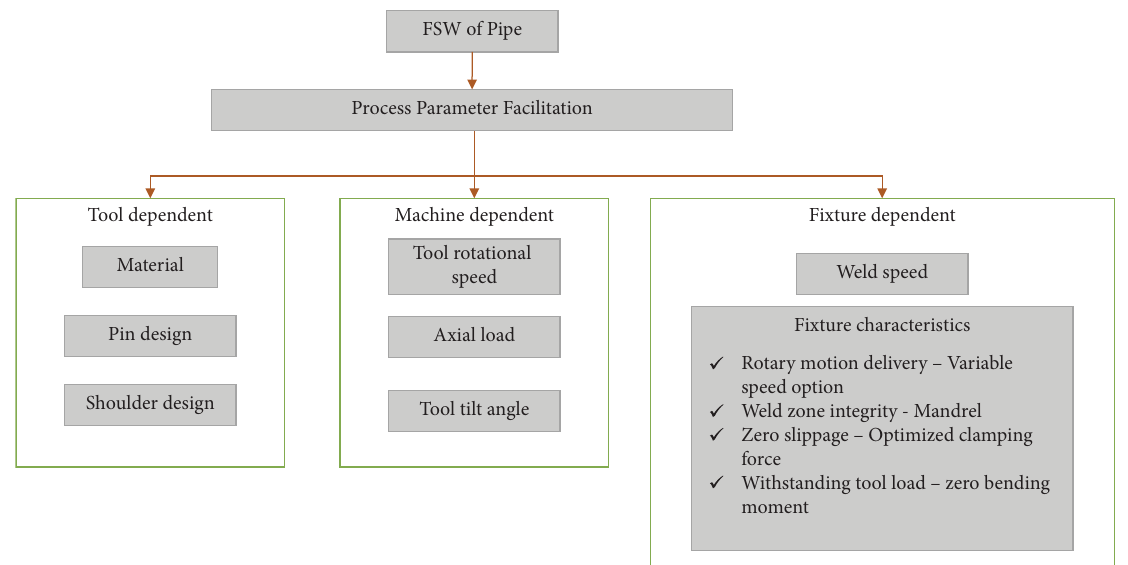
Figure 17: FSW of pipes–process facilitation chart as per the frst